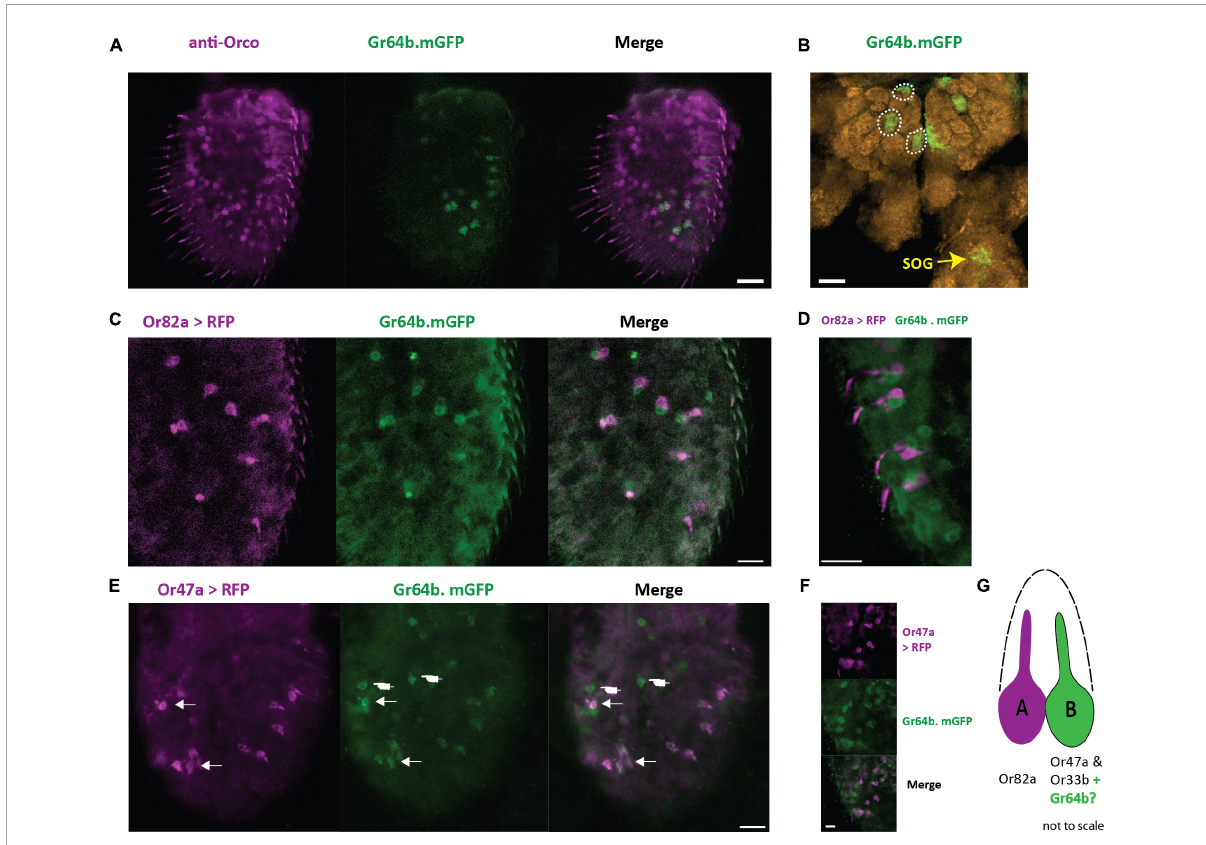
FIGURE2 Gr64b is co-expressed with Or47a-Or33b in ab5B neuron in D. melanogaster . (A) Staining of OSNs with anti-Orco antibody (magenta) and Gr64b expressing neurons tagged with GFP (green). Only a few cells are observed to be both Gr64b and Orco positive. Scale bar = 20 µ m. (B) Innervation of three glomeruli (VA6, DM3, and VM2) by Gr64b positive neurons. Green color denotes Gr64b positive glomeruli while orange color denotes neuropils with nc82 staining. Innervation of the subesophageal zone (SEZ) denoted in yellow arrow. (C,D) Double labeling crosses with Or82a-Gal4 driving expression of mRFP (magenta) and Gr64b tagged with GFP (green). No-colocalization is observed. However, Or82a and Gr64b positive neurons appeared to be in the close vicinity of each other suggesting innervation of the same sensillum. Scale bars = 10 µ m. (E,F) Double labeling crosses with Or47a-Gal4 driving expression of mRFP (magenta) and Gr64b tagged with GFP (green). Co-expression of Or47a was observed with Gr64b. All Or47a positive cells were also GFP positive (white arrow heads). However, a sub population with only Gr64b positive cells was also observed (white hand points). Scale bars = 10 µ m. (G) A schematic model for the new non-canonical innervation pattern of the ab5 sensillum class in D. melanogaster